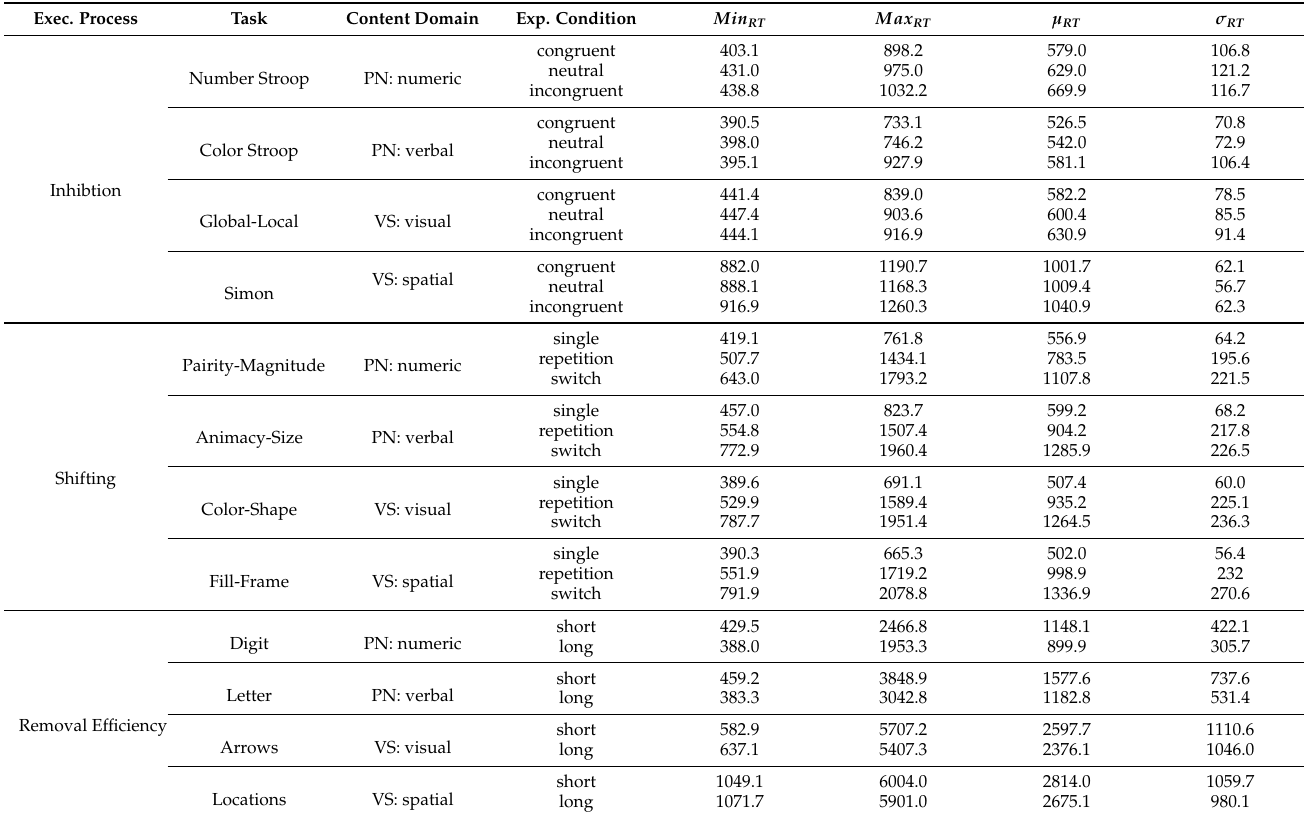
Table 2. Descriptive statistics of the mean response times (in ms) for correct responses in the executive processing tasks. Exec.